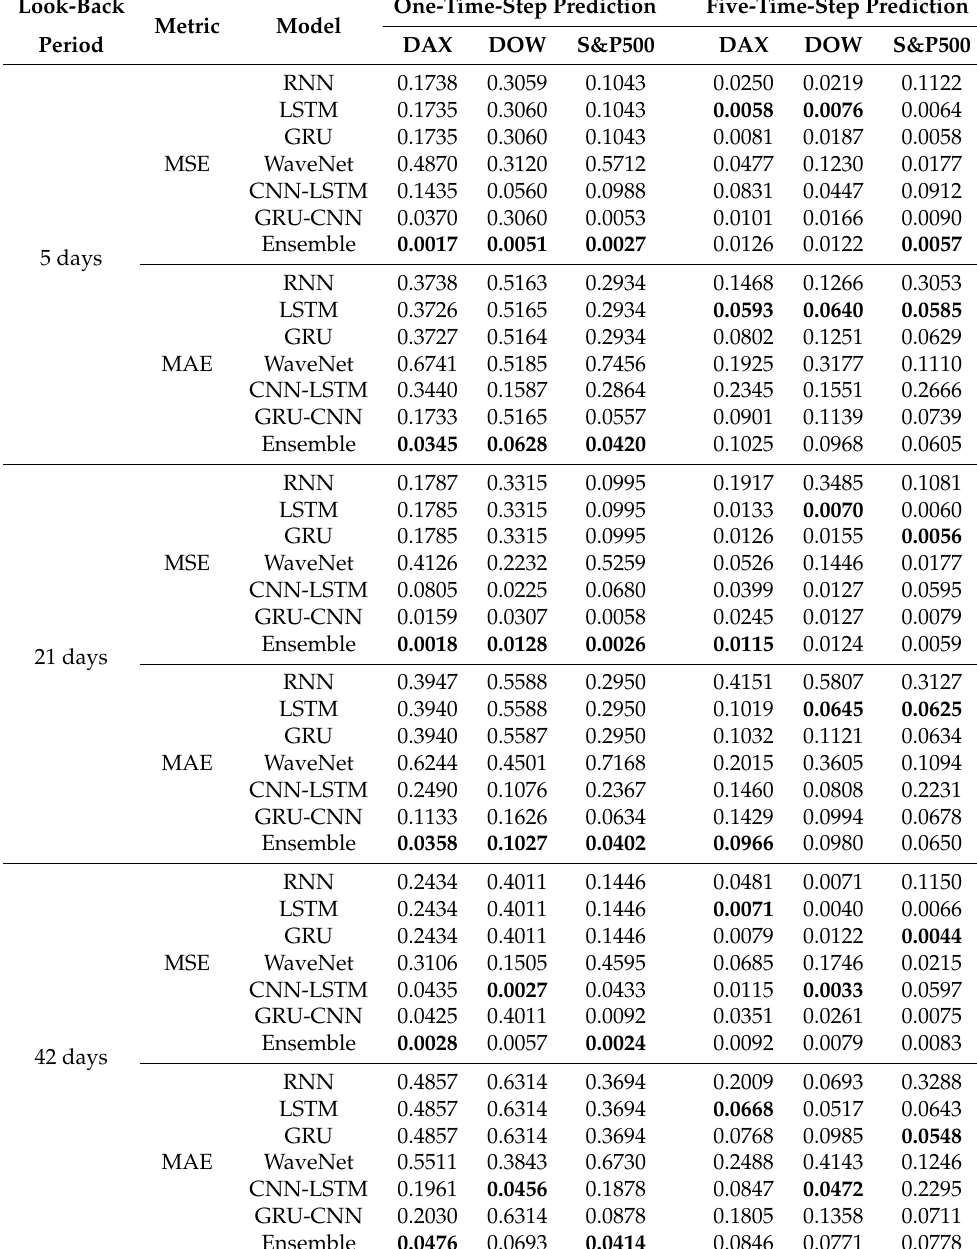
Table 9. Comparison of one-time-step and five-time-step predictions between proposed and bench- mark models for the period from 1 January 2021 through 15 February